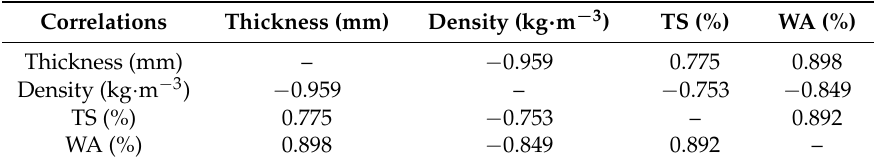
Table 7. Pearson correlation coefficient values for the physical dimensions and dimensional stability 1